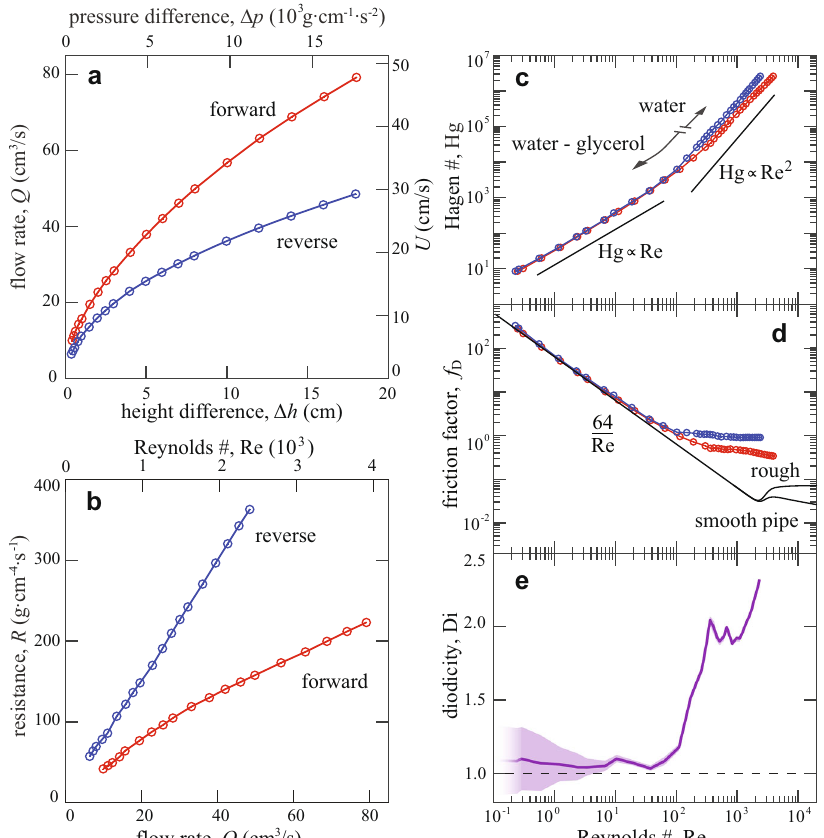
Fig. 2 Experimental characterization of Tesla ’ s conduit under steady pressures. a Flow rate Q across varying pressure heads Δ h and pressure differences Δ p = ρ g Δ h for the case of pure water as the working fl uid. The forward (red) and reverse (blue) directions exhibit different Q for the same Δ p . Here and elsewhere, error bars are suppressed when smaller than the symbol size (see text). b Hydrodynamic resistance R = Δ p / Q versus Q for the forward and reverse directions. c Dimensionless forms of pressure difference (Hagen number Hg) versus fl ow rate (Reynolds number Re). The plot combines data on pure water and water-glycerol solutions to cover a wide range of Re. d Friction factors f D = ( Δ p / L )/( ρ U 2 /2 D ), a dimensionless form of pressure drop appropriate for turbulent fl ow. Also shown are curves representing previous measurements for smooth and rough pipes. e Diodicity Di or ratio of reverse to forward resistances versus Re. The band represents propagated standard errors determined from repeated